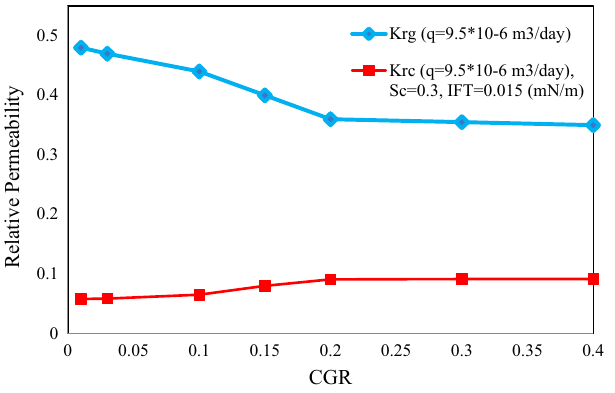
Figure 13. Changes in relative permeability of gas and condensate versus changes in